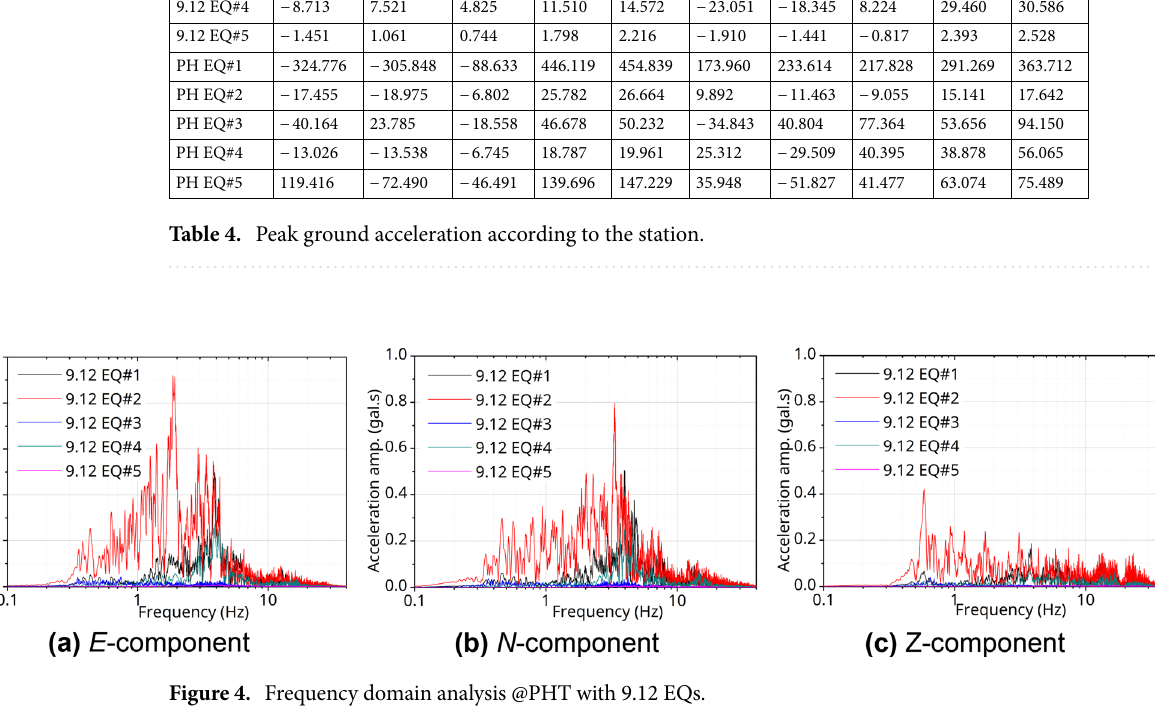
Figure 4. Frequency domain analysis @PHT with 9.12 EQs.